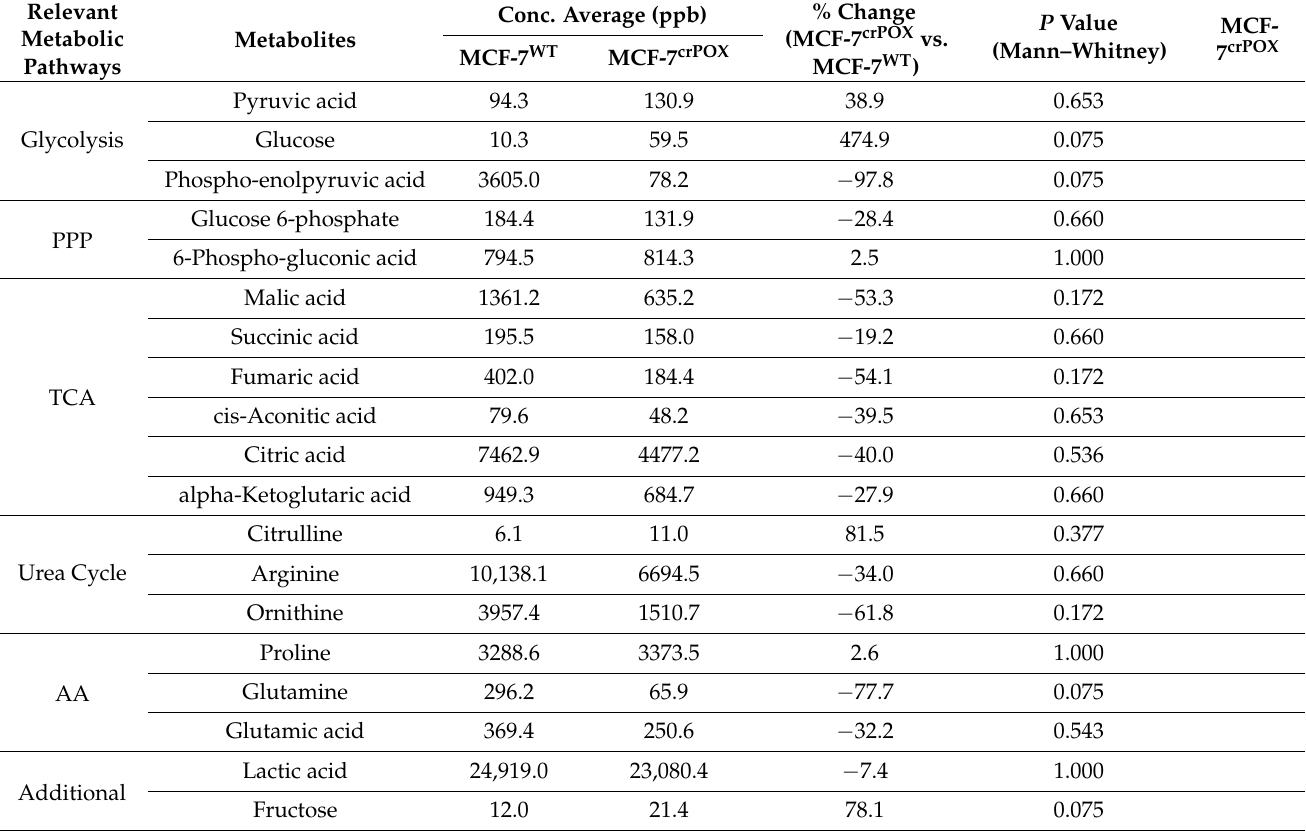
Table 4. Targeted metabolic profiles of some metabolites of glycolysis, pentose phosphate pathway, TCA and urea cycles in PRODH/POX-knock out of MCF-7 cells (MCF-7 crPOX ) and wild type MCF-7 cells (MCF-7 WT ) cultured in